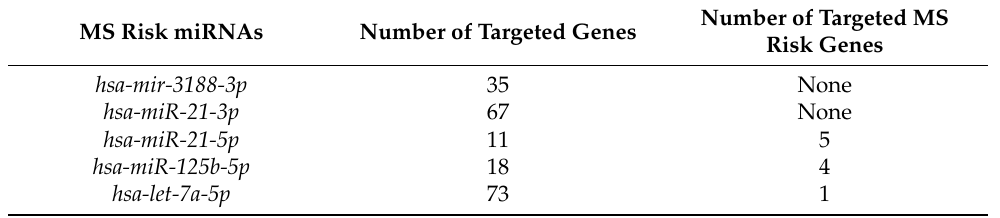
Table 3. Number of targeted MS risk genes by MS risk